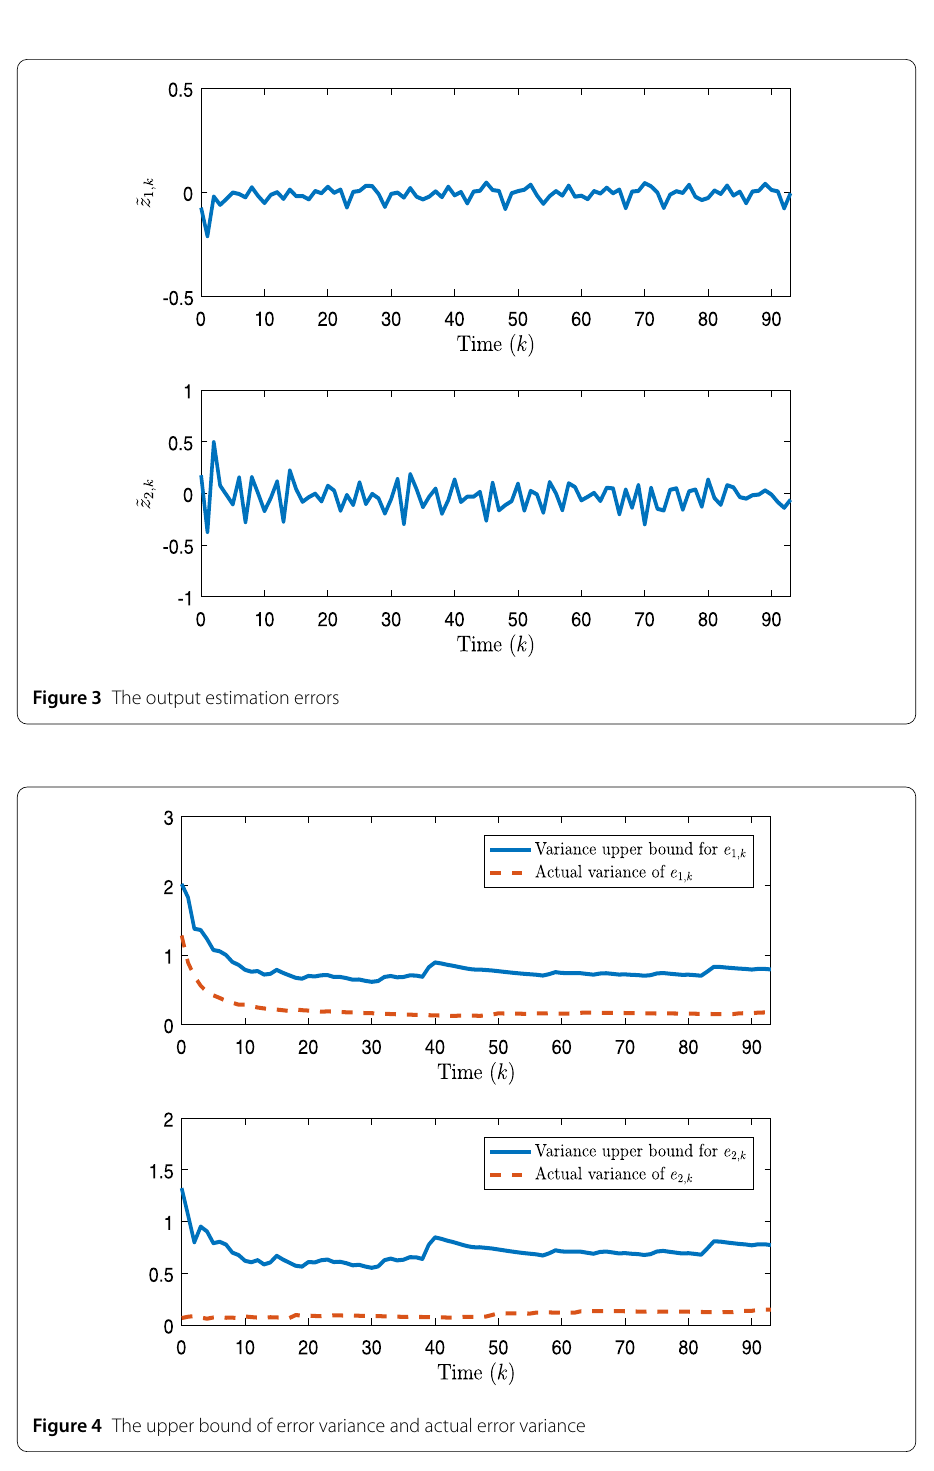
Figure 4 The upper bound of error variance and actual error